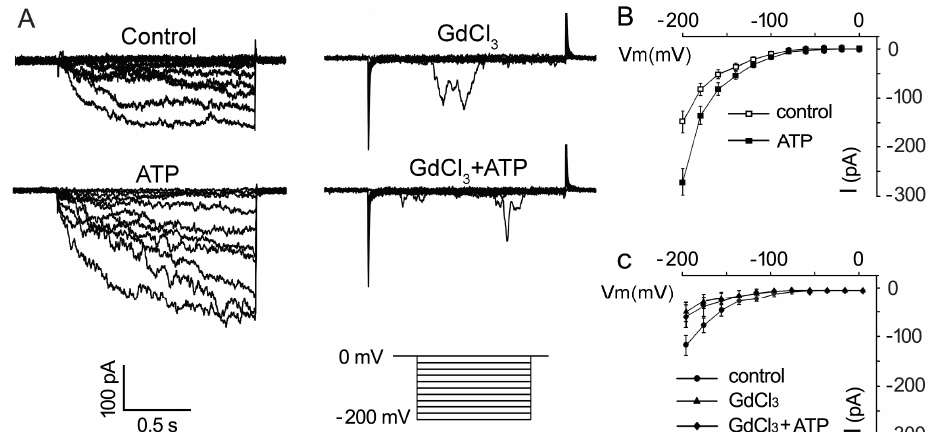
Figure 5. GdCl 3 inhibits eATP-stimulated Ca 2+ influx in the protoplasts of Arabidopsis pollen grain. ( A ) GdCl 3 (0.1 mM) inhibited resting and 0.1 mM ATP-stimulated inward Ca 2+ currents. Representative current traces from step-voltage clamping are shown. ( B , C ) I-V relationship curves of the inward Ca 2+ currents ( n = 7). In each experiment, data from 7 protoplasts were recorded and combined to obtain the mean ±